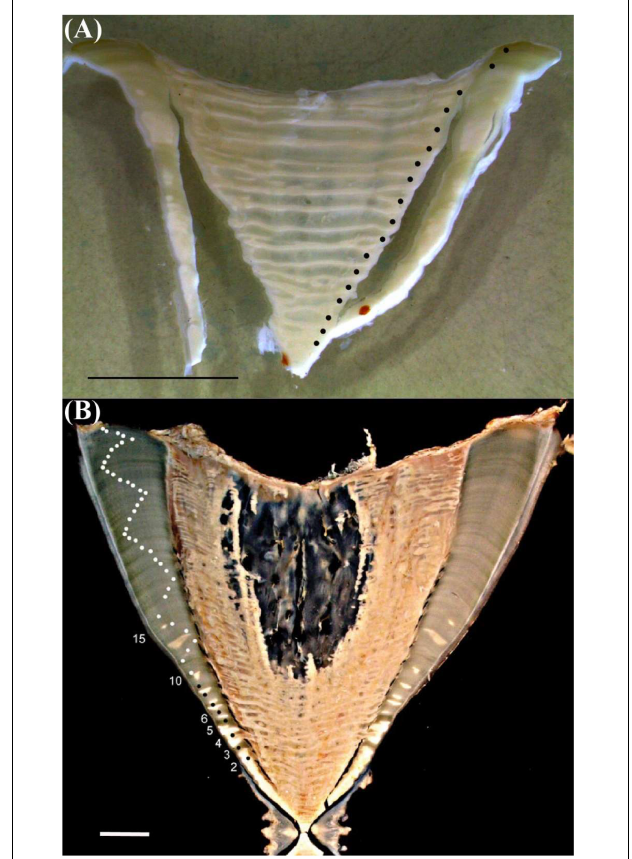
FIGURE 1 | Images of sectioned whale shark vertebrae with annotations of growth bands. (A) Vertebra from Taiwan (RT04) showing 18 growth bands. (B) Vertebra from Pakistan (RT20) used for bomb radiocarbon assay showing 50 growth bands. Scale bars – 1